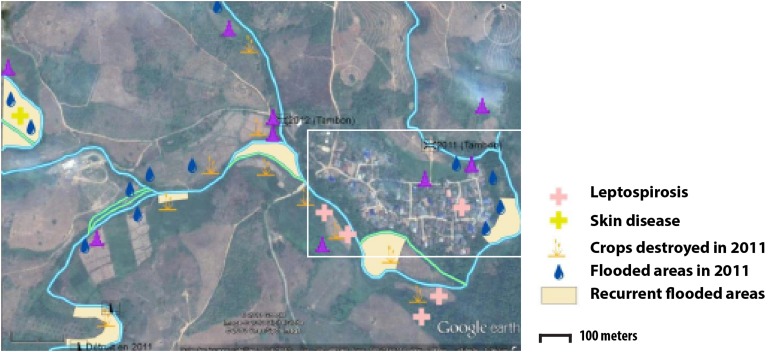
Results of the participatory mapping (see ‘Materials and methods’ section) showing the flooding areas and the unhealthy places according to risk perception of water-borne diseases.